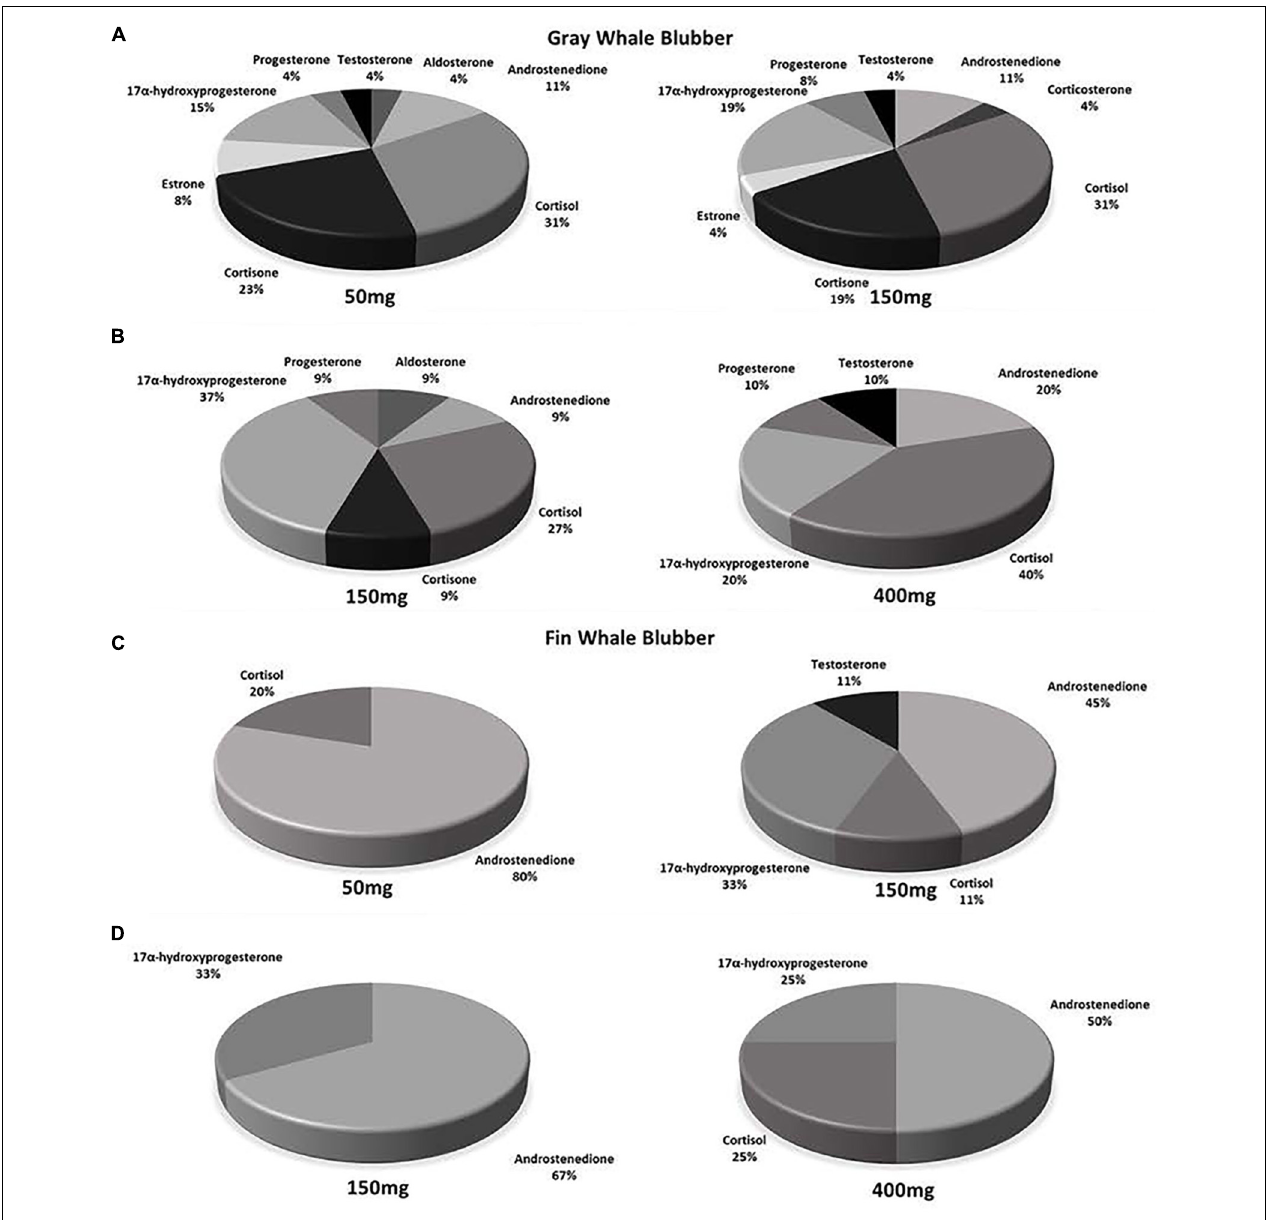
FIGURE 3 | Hormone detection profiles in 50, 150, and 400 mg ww paired blubber samples in gray and fin whales. (A) n = 15, (B) n = 6, (C) n = 6, and (D) n = 3. Percentages correspond to the proportion of samples where hormones were detected in relation to all samples within panel and mass